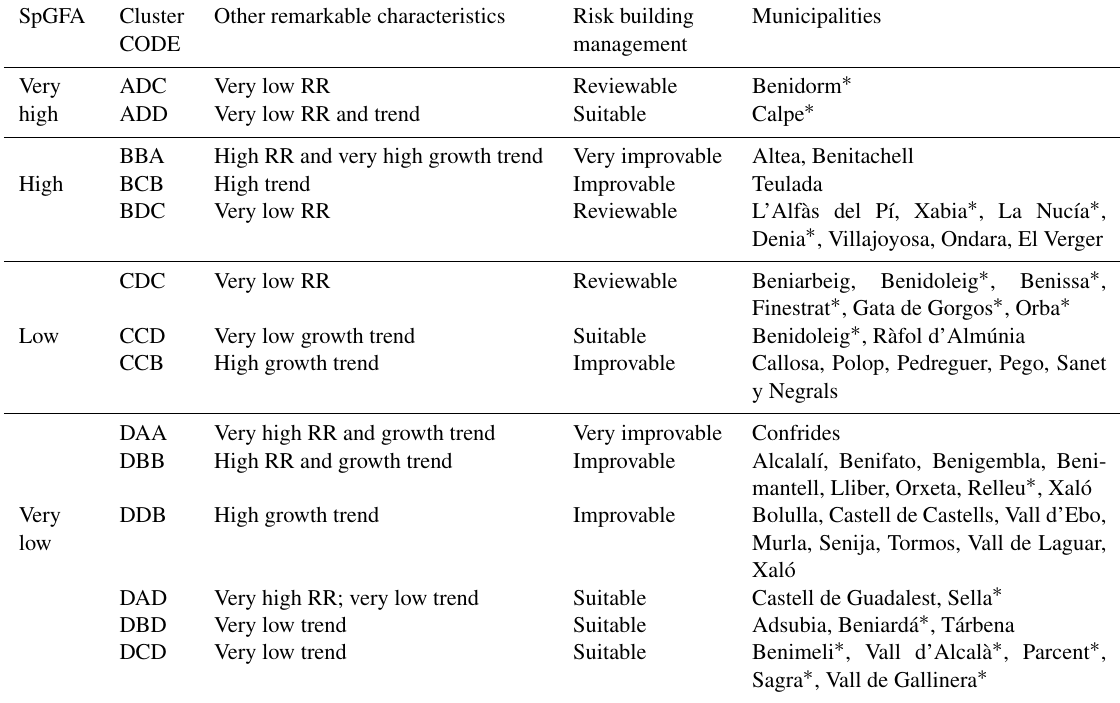
Table 9. List of clusters with their characteristics and municipalities assigned. Grouped by intensity construction ratio (SpGFA) from high to low.